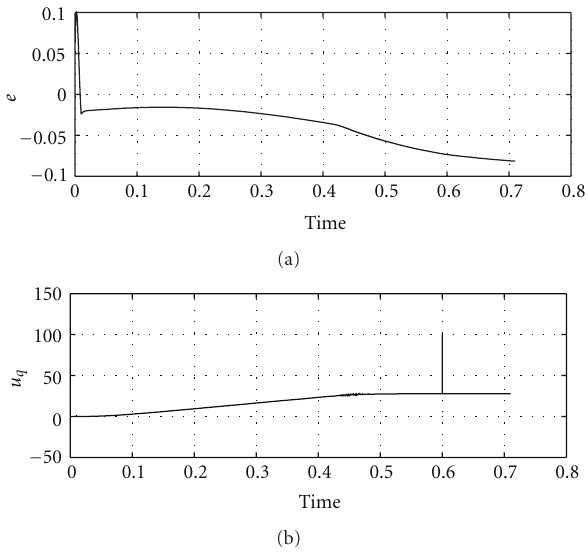
Figure 3: Performance of the tracking error and control input varying the damping constant